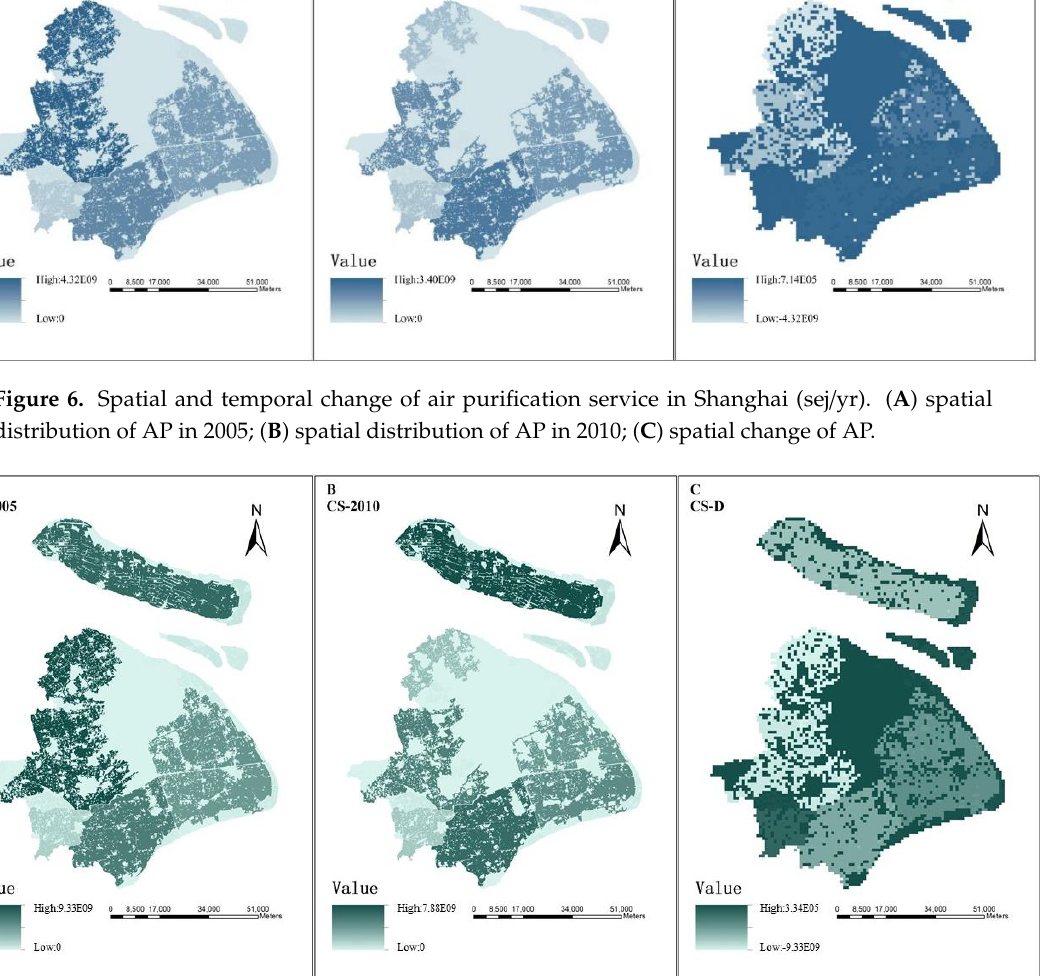
Figure 7. Spatial and temporal change of carbon sequestration service in Shanghai (sej/yr). ( A ) spatial distribution of CS in 2005; ( B ) spatial distribution of CS in 2010; ( C ) spatial change of CS.